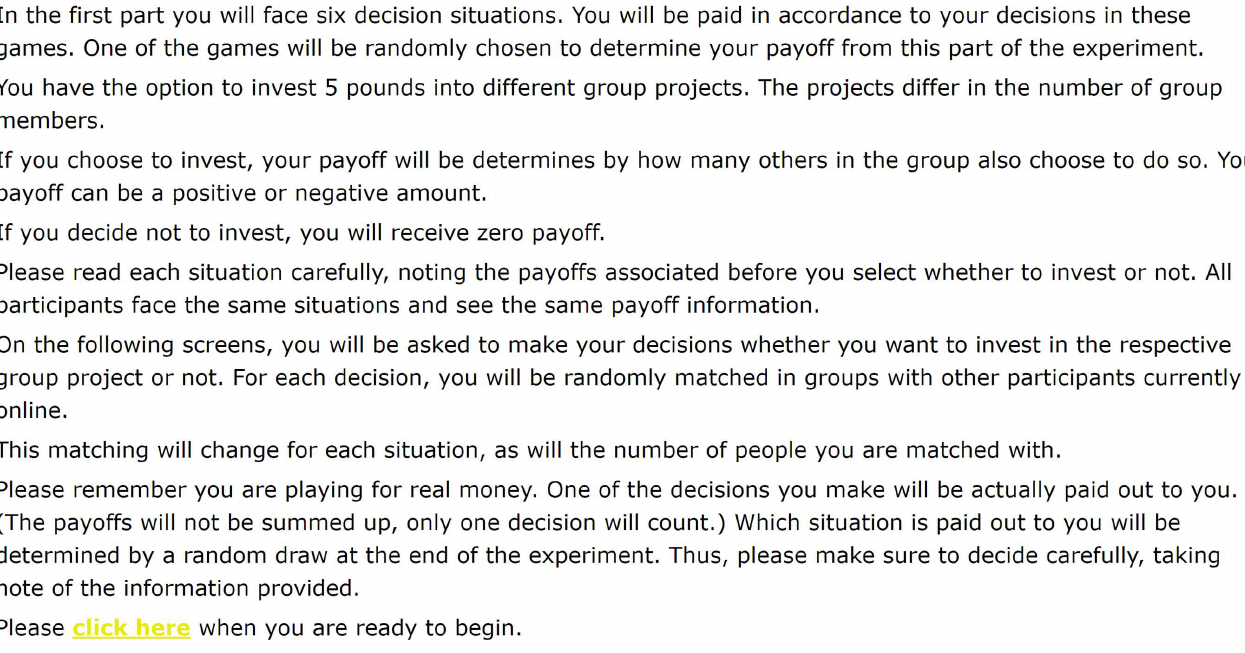
Fig 1. Screenshot—General